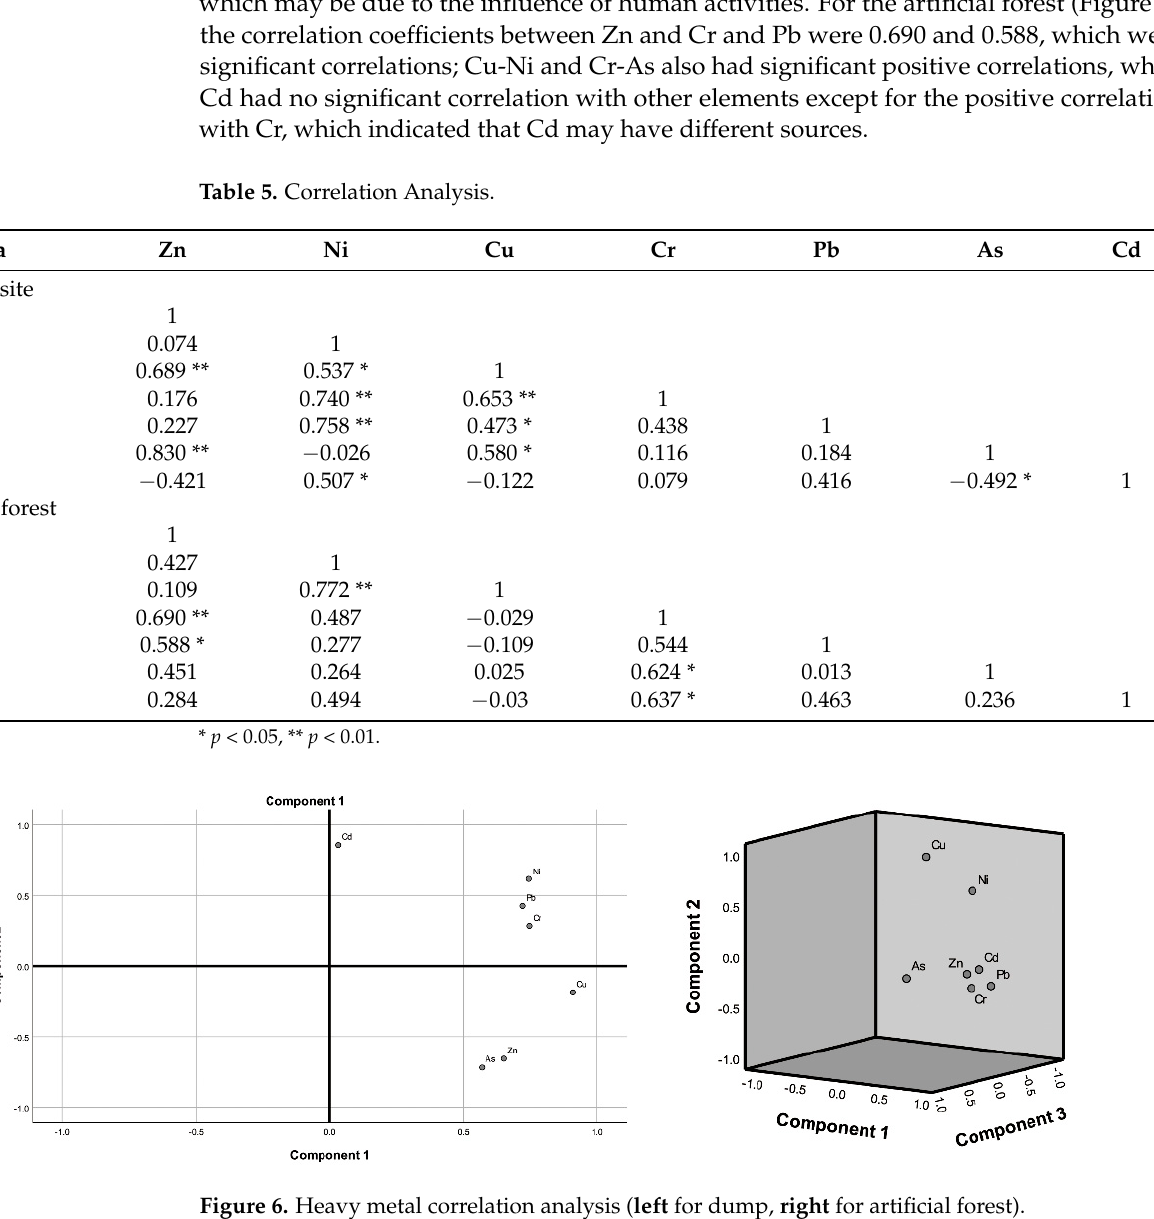
Figure 6. Heavy metal correlation analysis ( left for dump, right for artificial forest).